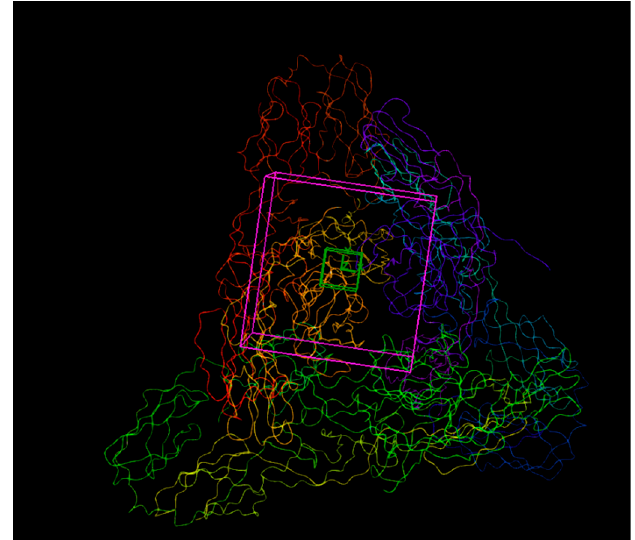
Figure A1. Docking grids used in molecular modeling of the trimeric complex of E1-E2 heterodimers. 36 Å docking grids (inner-box 10 Å and outer-box 46 Å) were prepared as described in the text of Appendix A.